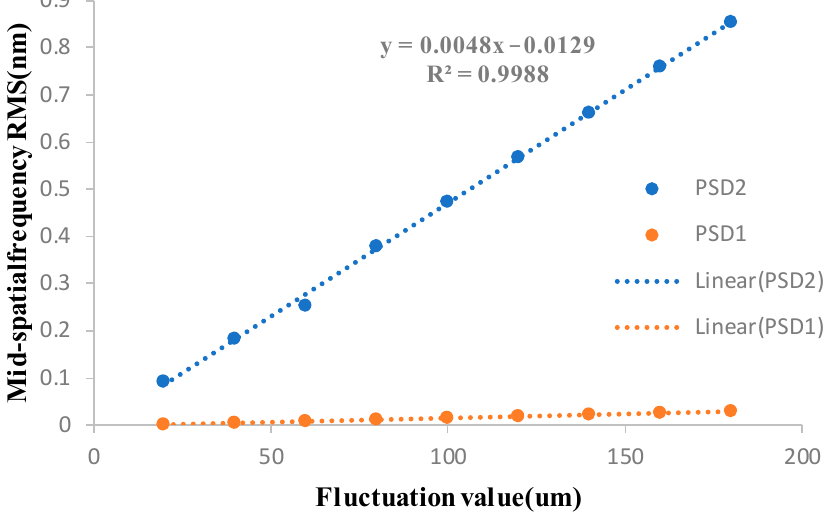
Figure 6. Effects of different ribbon fluctuations on PSD1 and PSD2 in the mid-spatial frequency